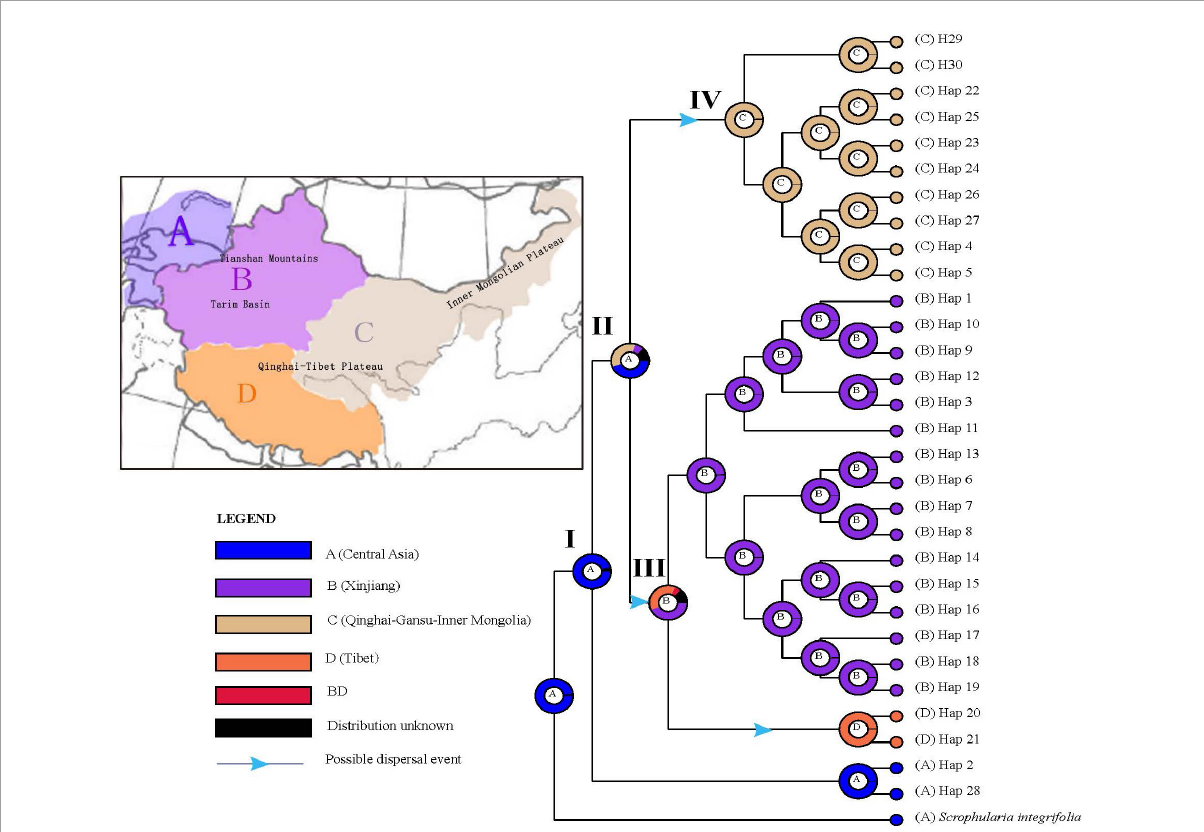
FIGURE6 Ancestral area reconstructions based on the Bayesian binary Markov chain Monte Carlo (BBM) method implemented in RASP using the BEAST-derived chronogram of Scrophularia incisa complex (see Figure 2 ). The insert map shows major floristic divisions (A–D) . Pie charts of each node illustrate the marginal probabilities for each alternative ancestral area derived from BBM with the maximum area number set to four. The color key identifies possible ancestral ranges at different nodes. Possible dispersal events are indicated by blue